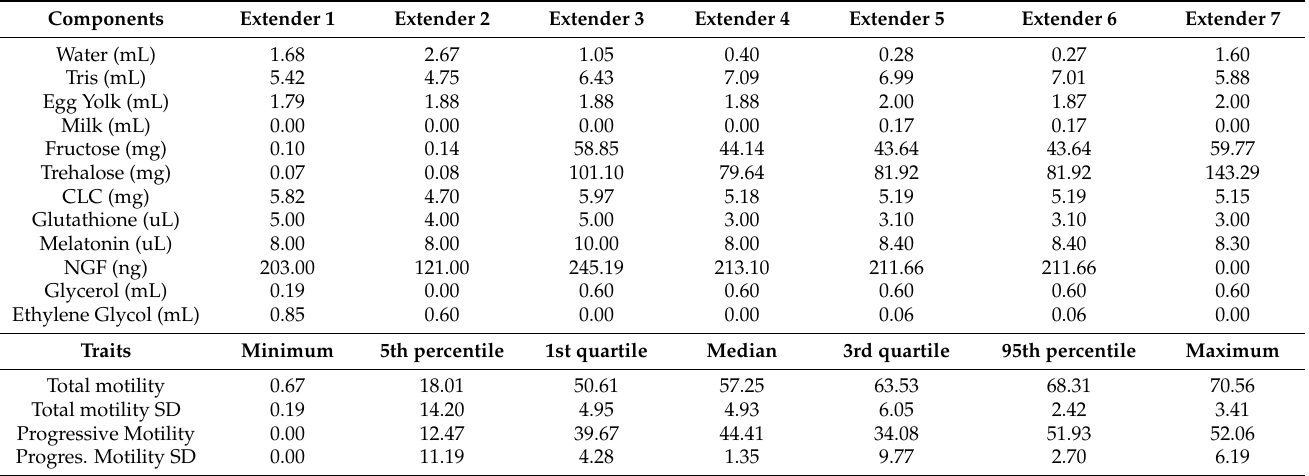
Table 2. Minimum, maximum, and percentiles of the treatments in terms of total motility obtained from the I-optimal design. In addition, for the same treatments, the values and standard deviation (SD) of progressive motility were